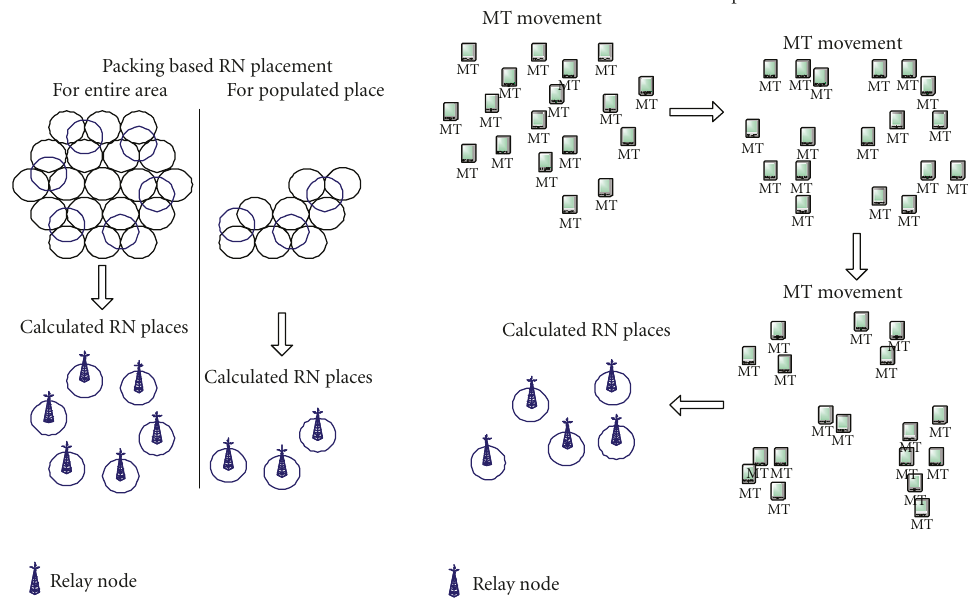
Figure 3: Packing-based RN placement and heuristic RN